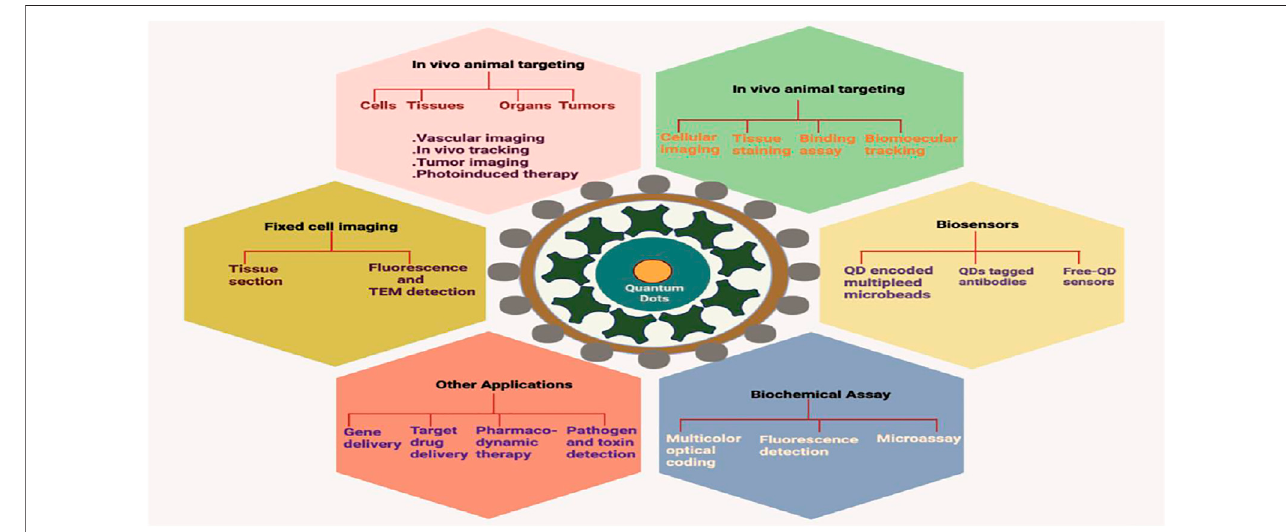
FIGURE 2 | Various applications of Quantum dots in bioimaging and